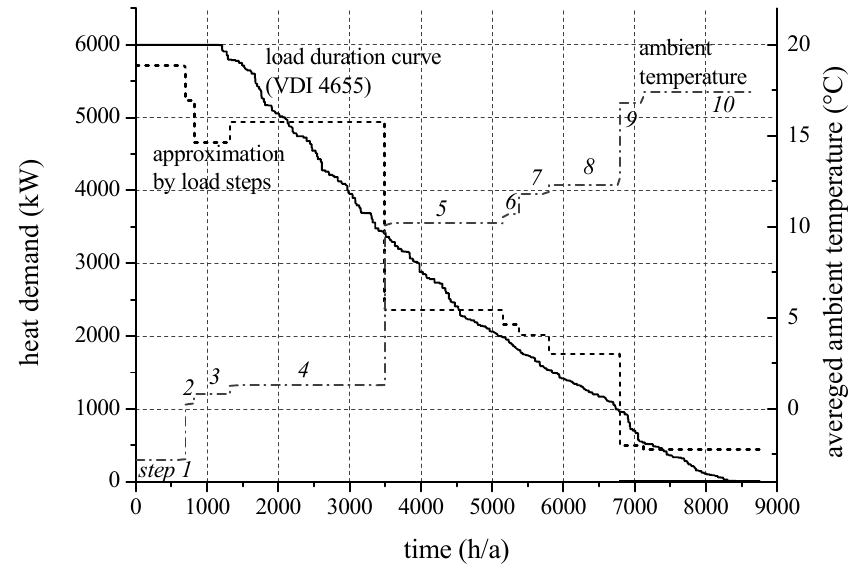
Figure 4. Annual duration curve of the heating network and approximation by load steps corresponding to the averaged ambient temperature of the considered climatic